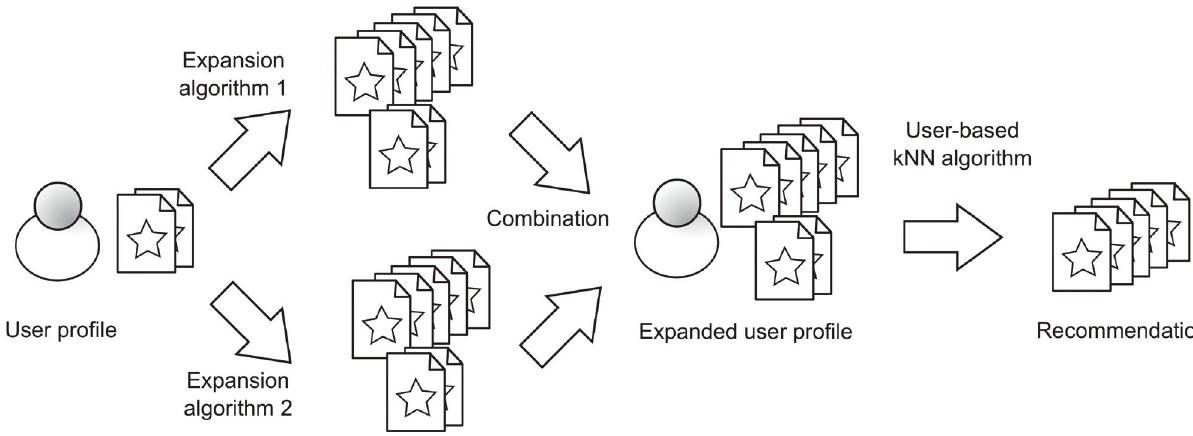
Fig 3. Recommendation process using High Order Profile Expansion with the parallel alternative.